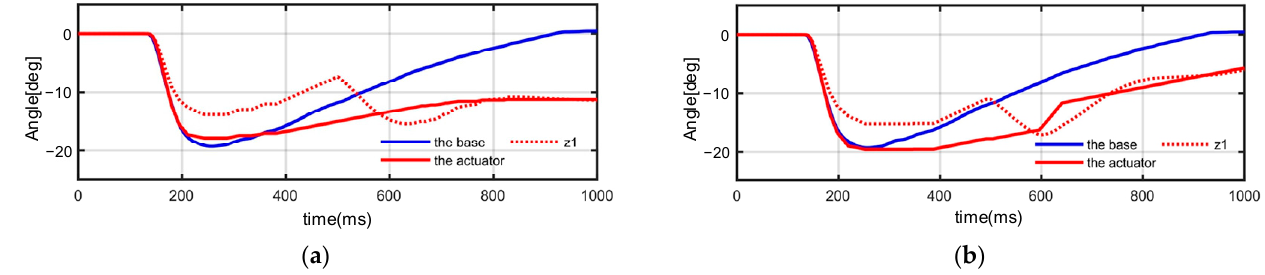
Figure 7. The effect of the compensation by the angular observation: ( a ) controlled by the feedforward solitary; ( b ) adding the compensation by z 1 .